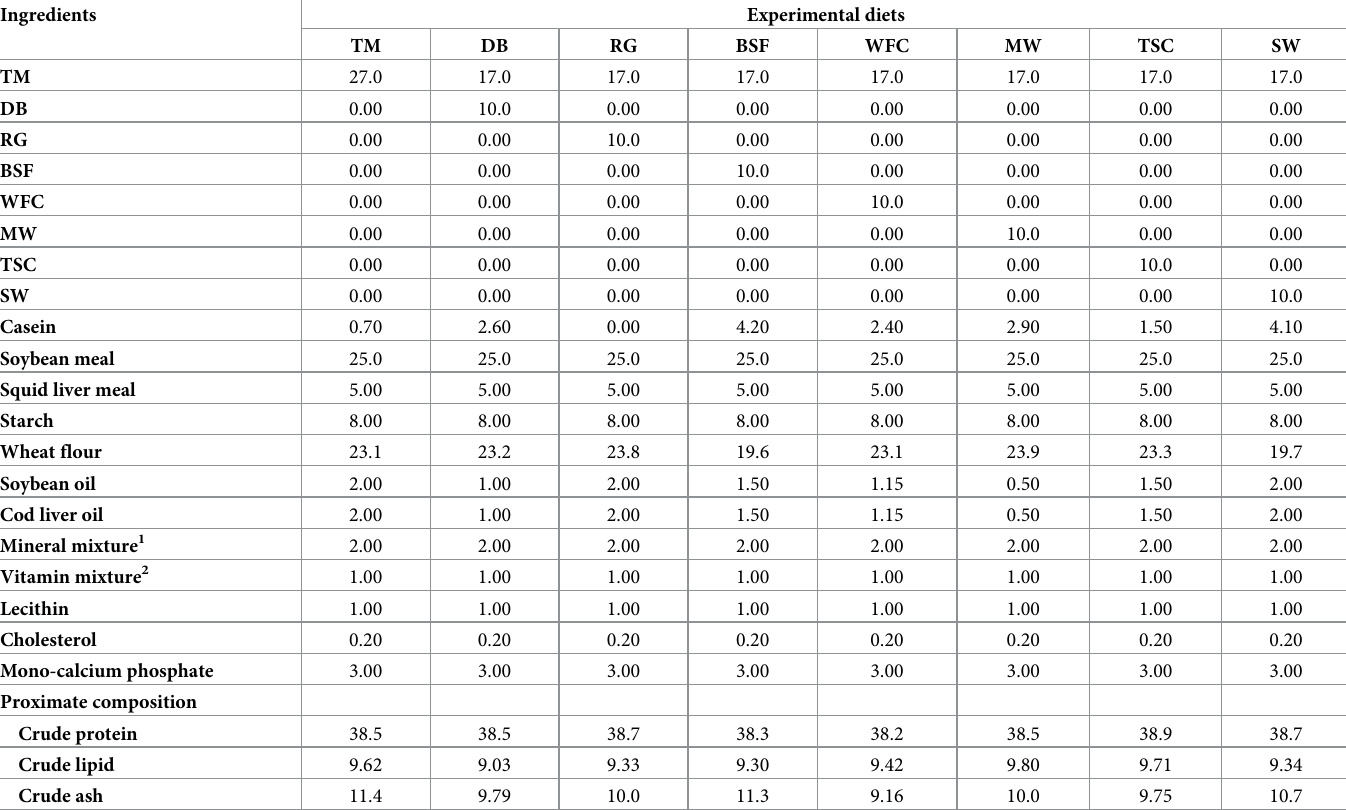
Table 4. Formulation and proximate composition (%, dry matter) of the experimental diets for the feeding trial of Pacific white shrimp ( Litopenaeus vannamei ).